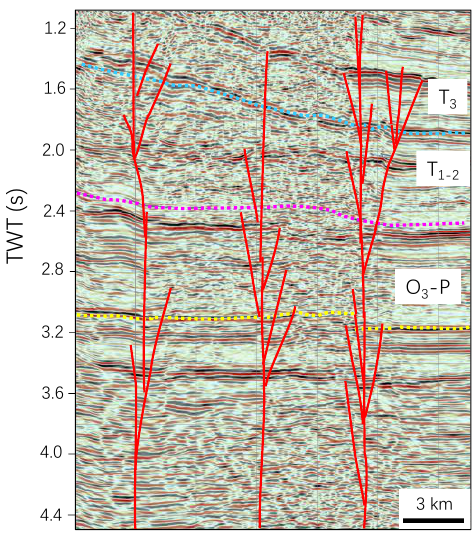
Figure 4. Typical seismic section showing three layered fault zones in this study area (T 3 : the Upper Triassic; T 1 – 2 : the Lower-Middle Triassic; P: the Permian; O 3 : the Upper Ordovician).